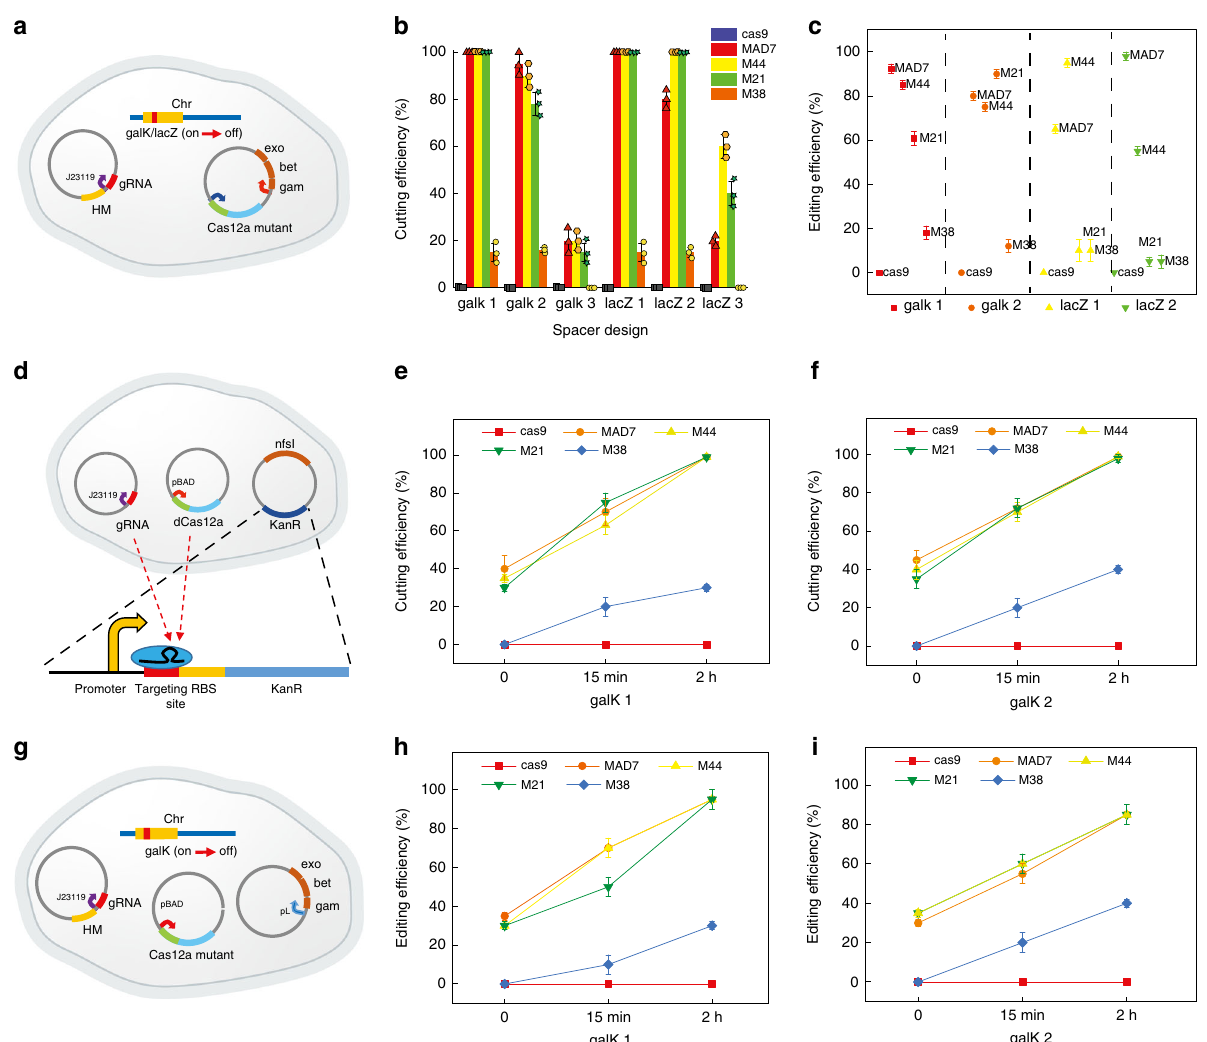
Fig. 3 The genome-editing test with different gRNAs for chimera library variants in E. coli . a Editing (cutting) ef fi ciency test using gRNA targeting galK or lacZ genes. We constructed a two plasmid system for genome editing: one plasmid expresses a Cas protein as well as lambda red proteins (exo, bet, and gam) 67 ; a second plasmid expresses a single crRNA (with J23119 promoter) targeting the galK or lacZ gene and a homology arm (HM) containing a gene- inactivating mutation. For the cutting, there were no lambda red proteins or homology arm in the system. b Cutting ef fi ciency of chimeric Cas12a-like proteins using six different gRNA plasmids (online methods). The gRNA plasmids galK1, galK2, and galK3 targeted different positions in the galK gene. The gRNA plasmids lacZ1, lacZ2, and lacZ3 targeted different positions in the lacZ gene. c The editing ef fi ciency of chimera library variants with different gRNAs. The gRNAs used in the test were galK1, galK2, lacZ1, and lacZ2. Editing ef fi ciency was determined by color screening (red/white for GalK or blue/ white for LacZ). d The dCas12a (or Cas12a with reduced activity) protein binding assay. We constructed a three plasmid system: one plasmid expresses dCas12a (or Cas12a with reduced activity) using a arabinose inducible promoter (pBAD); a second plasmid expresses a single crRNA (with J23119 promoter) targeting the kanR gene; a third plasmid expresses the kanamycin resistance protein (encoded by kanR gene) using a constitutive promoter containing a fully complementary (on-target) crRNA binding site as well as a nitroreductase (encoded by nfsI gene) which makes the cells sensitive to metronidazole. e , f The cutting ef fi ciency of chimeric Cas12a-like nucleases with different arabinose induction times using different gRNA. e galK_1 and f galK_2. g The arabinose inducible system for chimeric Cas12a-like proteins. We constructed a three plasmid system for genome editing: one plasmid expresses a Cas12a-like protein using a arabinose inducible promoter; a second plasmid expresses lambda red proteins (exo, bet, and gam) using a temperature-inducible promoter (pL); a third plasmid expresses a single crRNA (with J23119 promoter) targeting the galK gene with homology arm (HM) containing a galK -inactivating mutation as a template for recombineering. h , i The editing ef fi ciency of chimeric Cas12a-like nucleases with different arabinose induction times using different gRNA. h galK_1 and i galK_2. Source Data are available in the Source Data